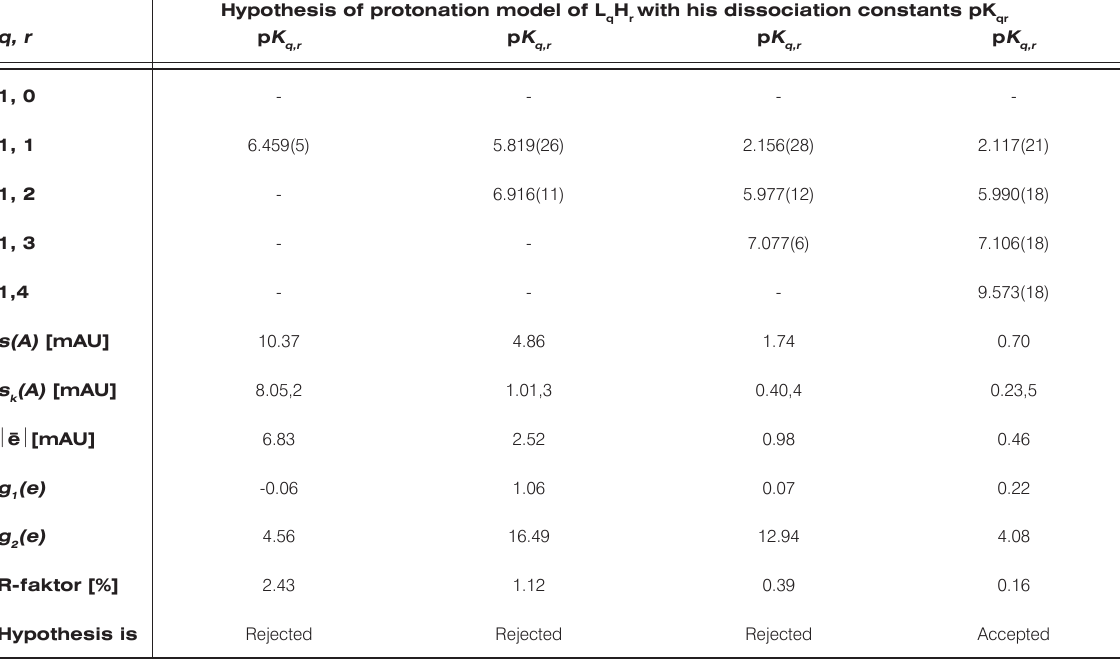
Hypothesis of protonation model of L